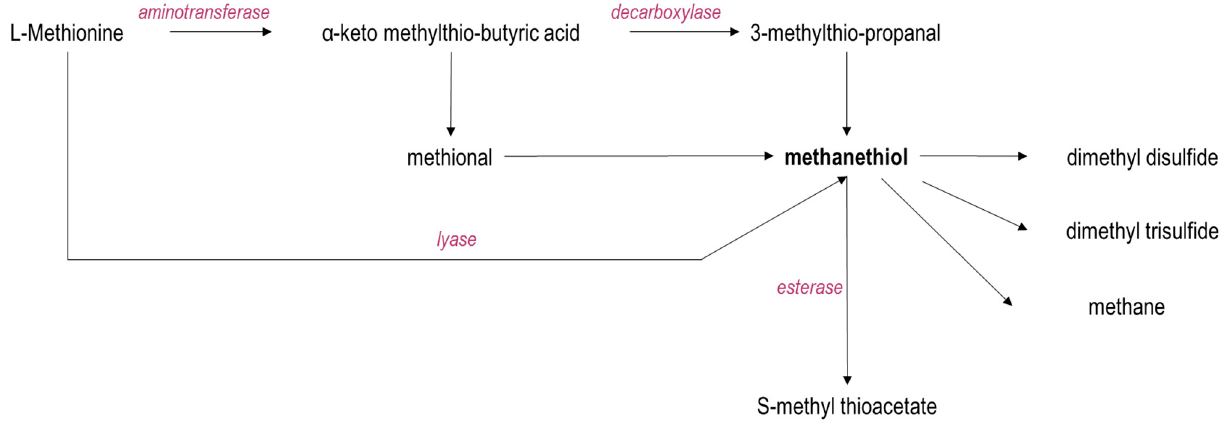
Figure 3. Schematic presentation of the formation of